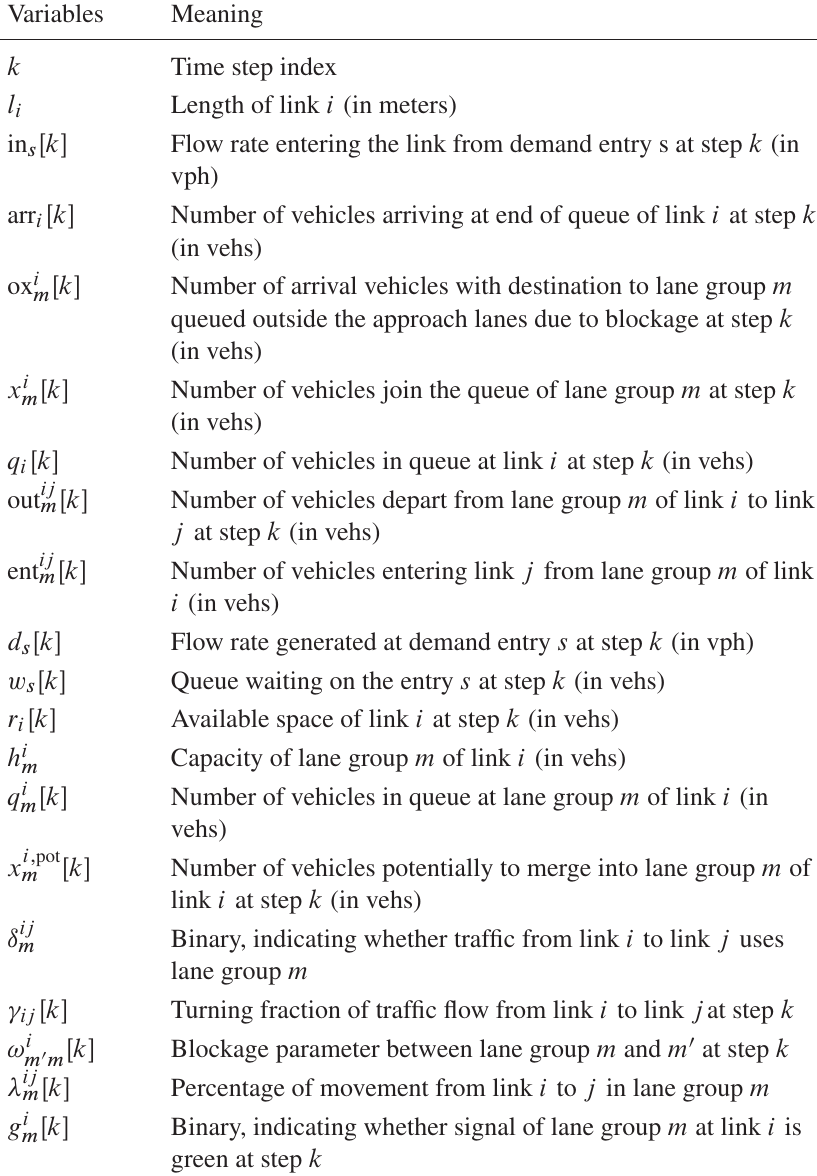
Table 1. List of key variables used in the